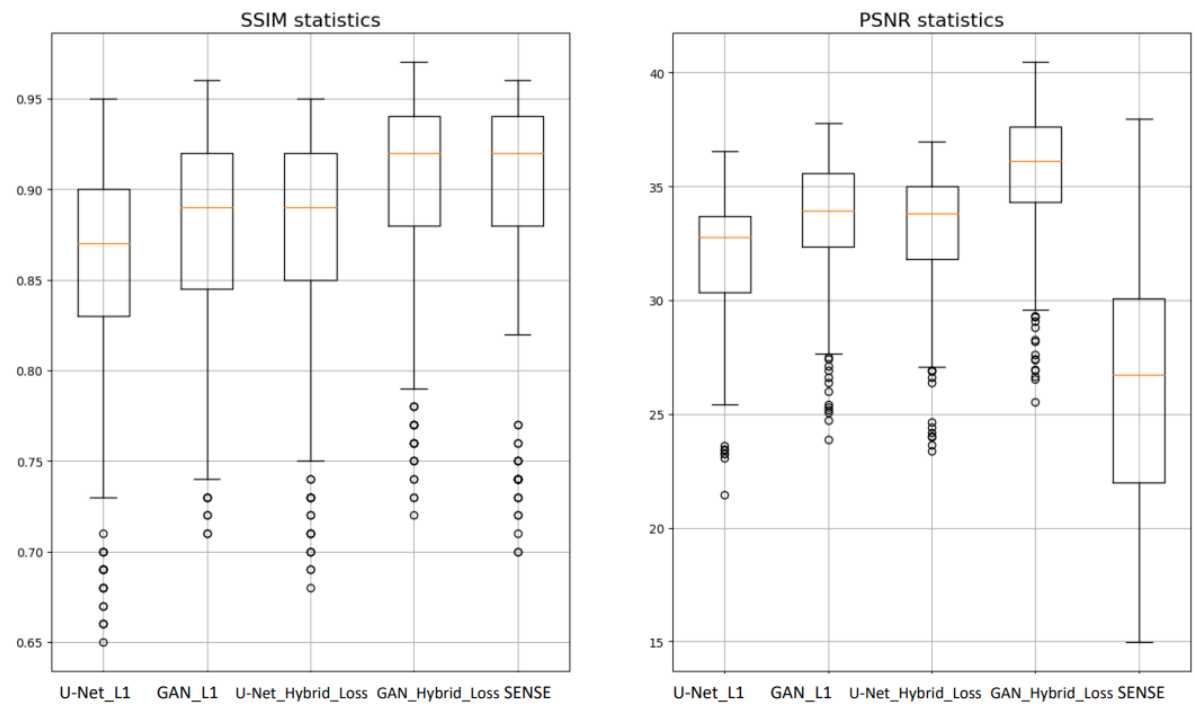
Figure 6. Comparison of the SSIM and PSNR metrics of the reconstructed test images for different algorithms: U-Net model with the L1-loss ( U-Net_L1 ), U-Net model with the combination of the L1- and Fourier loss ( U-Net_L1_fft ), CGAN model with the L1-loss ( GAN_L1 ), CGAN model with the combination of the L1 and Fourier losses ( GAN_L1_fft ), and the classic SENSE reconstruction. Table 2. Reconstruction performance evaluation of the proposed methodology against SENSE over the test dataset.